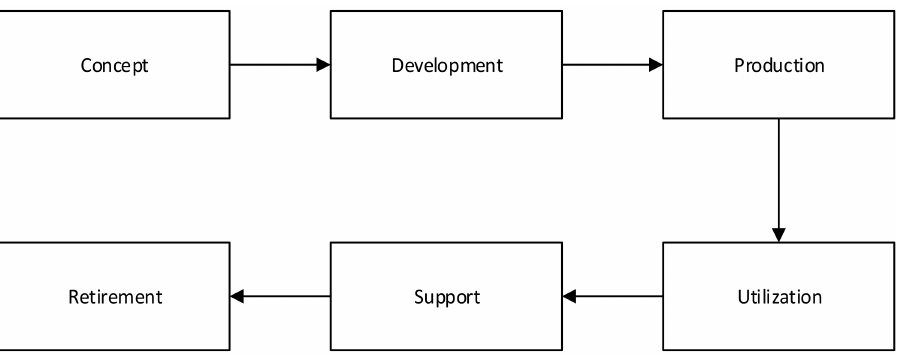
Figure 5. Recommended lifecycle by NIST SP